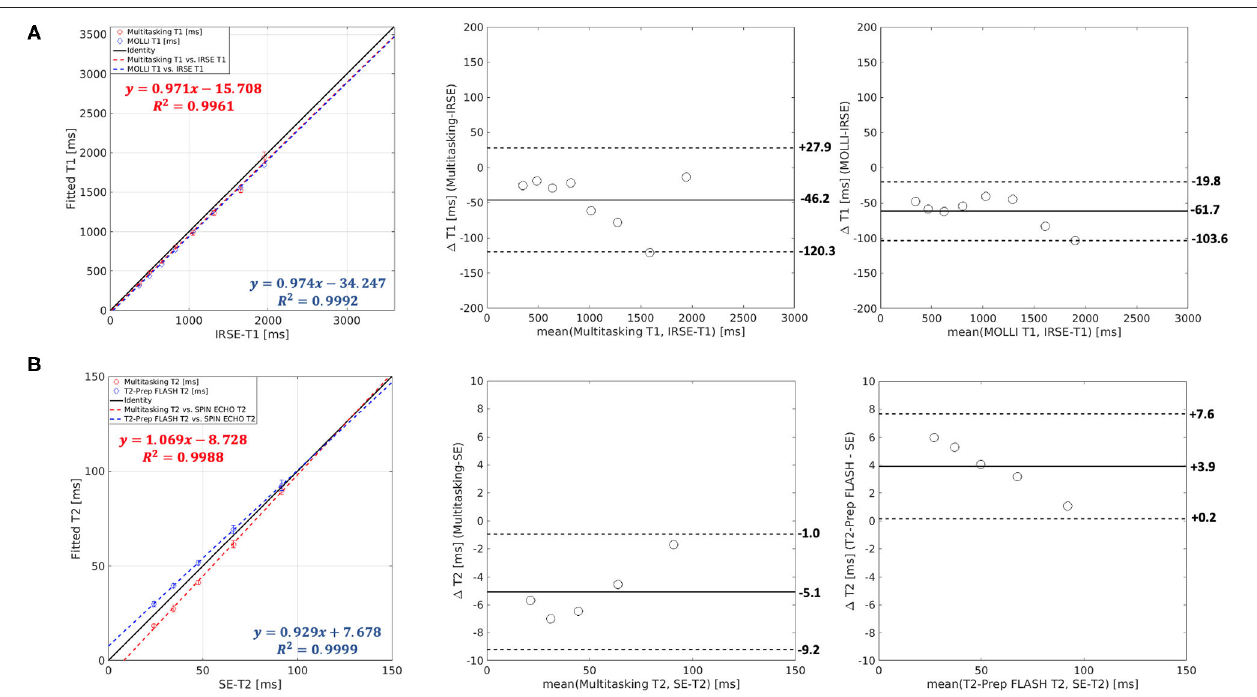
FIGURE 4 | (A) Both Multitasking-SMS and MOLLI showed high R 2 values against inversion recovery spin echo (IRSE)-T1 in the linear regression. The T1 bias and limits of agreement were − 46.2 ± 74.1ms for Multitasking-SMS and IRSE-T1, and − 61.7 ± 41.9ms for MOLLI and IRSE-T1. (B) Both Multitasking-SMS and T2-prep FLASH showed a high R 2 value against SE-T2. The T2 bias and limits of agreement were − 5.1 ± 4.1ms for the Multitasking-SMS and SE-T2, and 3.9 ± 3.7ms for T2-prep FLASH and